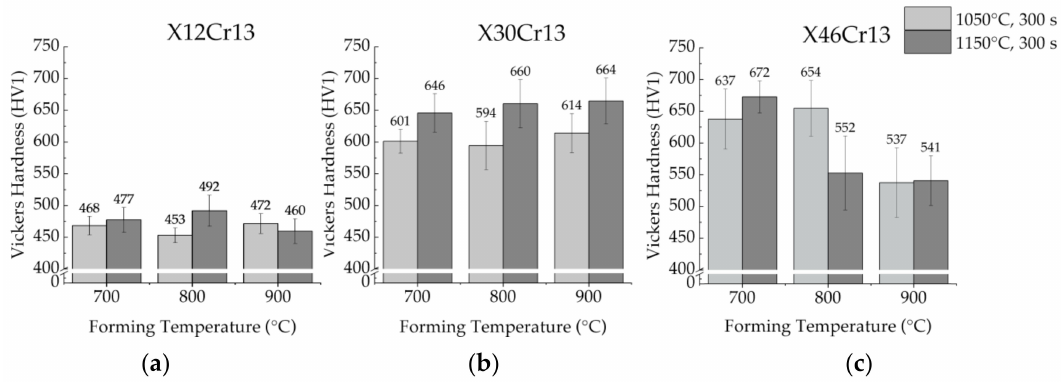
Figure 10. Mean hardness HV1 and standard deviation of the cup cross section for thermomechanical treatment after initial austenitization at 1050 ◦ C / 300 s or 1150 ◦ C / 300 s and forming at 700 ◦ C, 800 ◦ C and 900 ◦ C for the X12Cr13 ( a ), X30Cr13 ( b ) and X46Cr13 ( c )